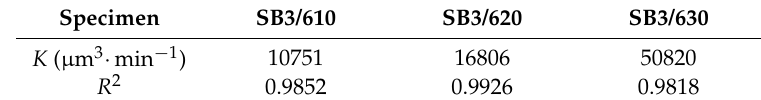
Figure 6. Microstructures of several materials: ( a ) SB3/610 ‐ 1; ( b ) SB3/610 ‐ 10; ( c ) SB3/610 ‐ 30; ( d ) SB3/620 ‐ 1; ( e ) SB3/620 ‐ 10; ( f ) SB3/620 ‐ 30; ( g ) SB3/630 ‐ 1; ( h ) SB3/630 ‐ 10; and ( i ) SB3/630 ‐ 30. Table 2. K values and coefficients of determination obtained via linear fitting using Lifshitz ‐ Slyozov ‐ Wagner (LSW) theory for SB3 with various salt bath temperatures. SB3: salt bath material with 3 mm thickness.